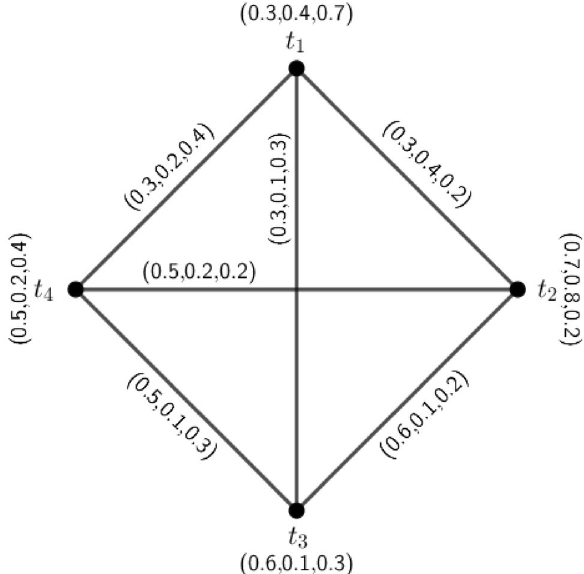
Figure 6. A 3PFG Γ 3 is complete but not